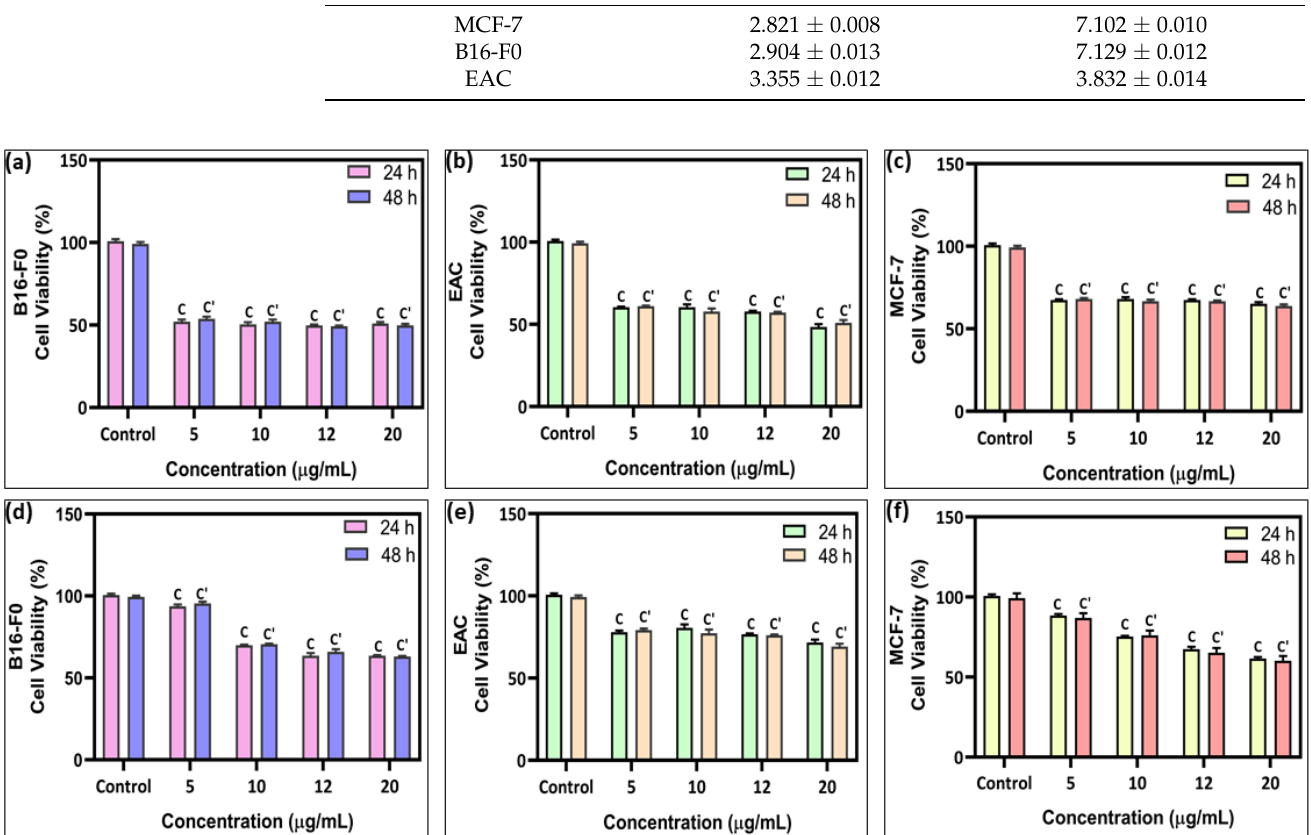
Figure 4. Anticancer potential of ( a – c ) 3-MBTSc and ( d – f ) 4-NBTSc compounds on B16-F0, EAC, and MCF-7 cells. The toxicity was measured by MTT in a dose-dependent manner till 48 h. All the experiments were conducted three independent times and each treatment was kept in triplicates (n = 3). c, c’ = *** p < 0.001. Table 3. IC 50 values of 3-MBTSc and 4-NBTSc compounds on different cancer cells.